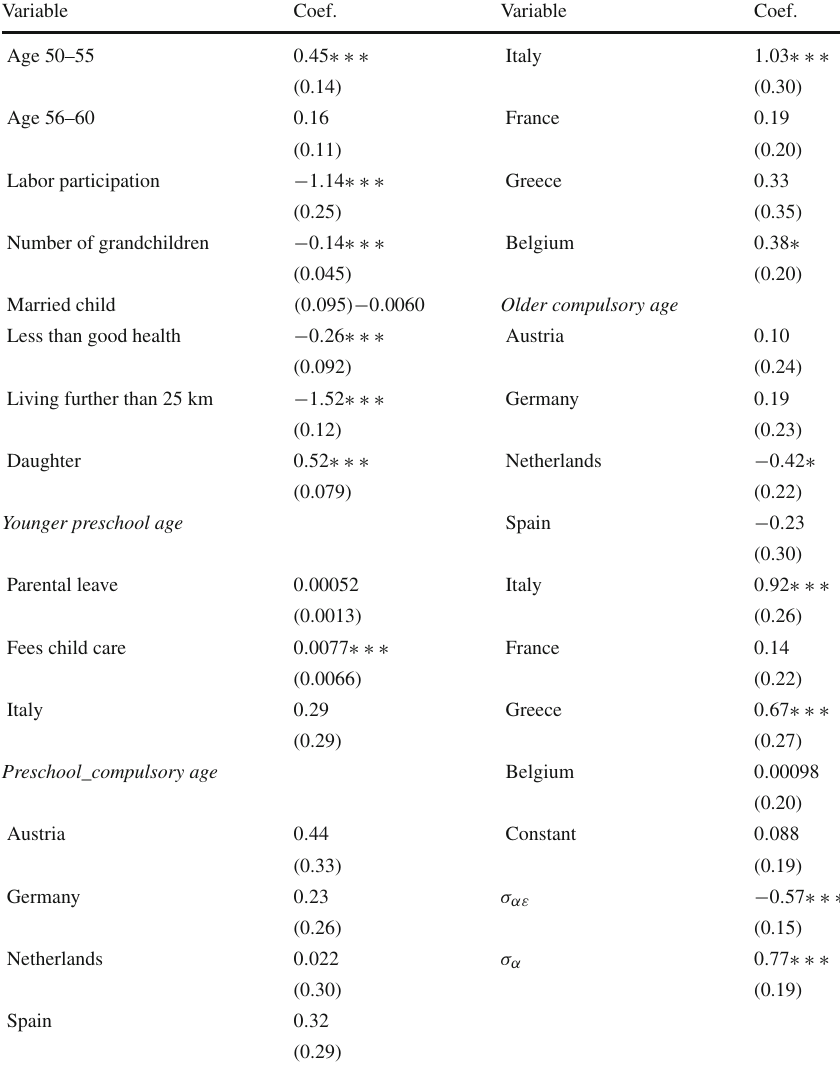
Table 11 Maximum likelihood estimates. Caregiving decision Variable